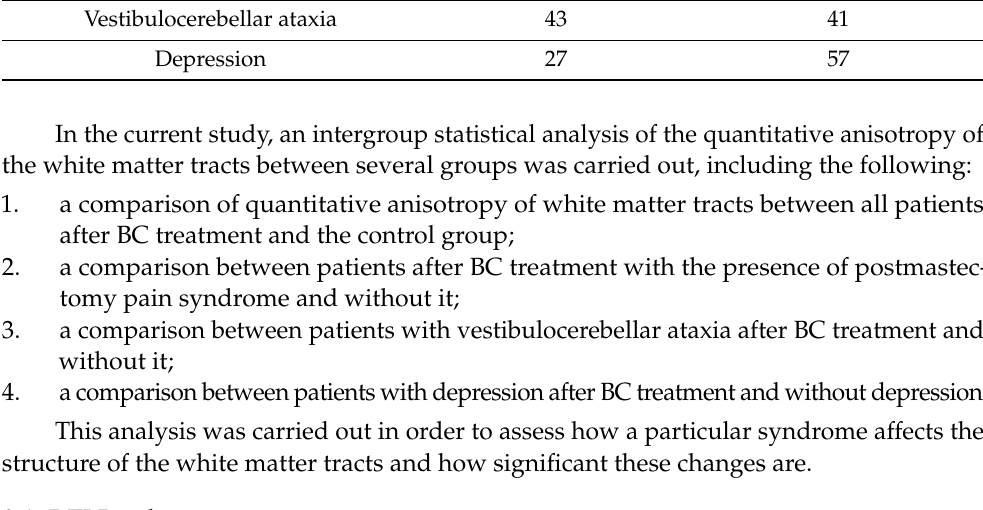
Table 3. The number of patients in groups, depending on the syndromes.